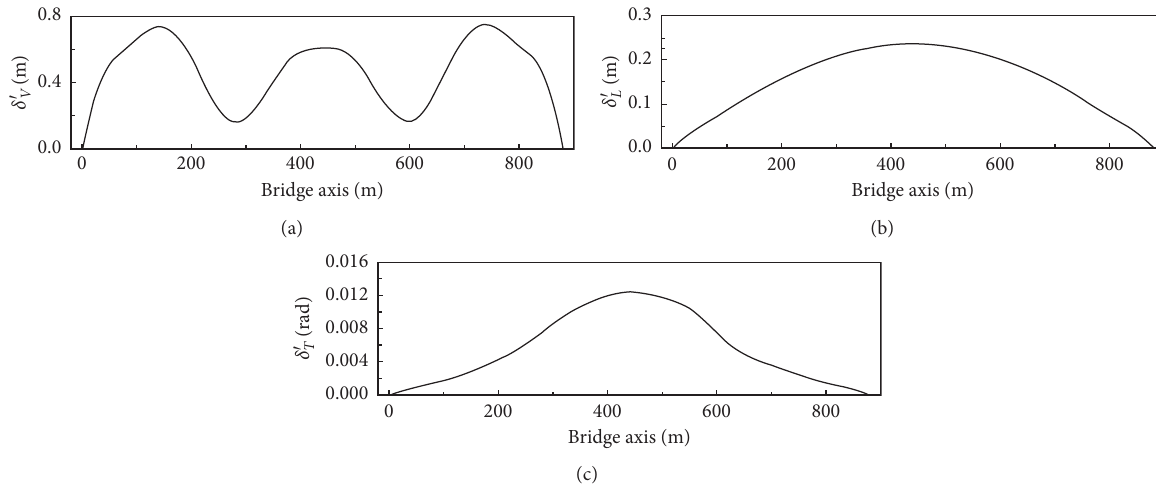
Figure 14: Root-mean-square (RMS) buffeting displacements of the original design final configuration (Case 1) at AoA of 0 ° : (a) vertical displacement δ V ′ ; (b) lateral displacement δ L ′ ; (c) torsional displacement δ T ′